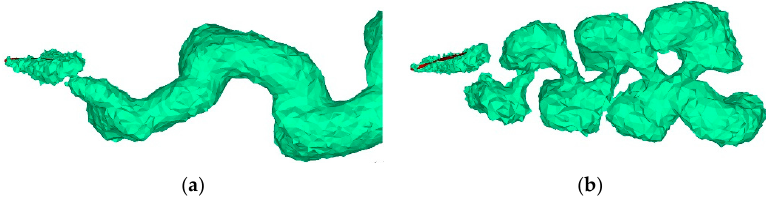
Figure 13. Vortex pattern in the wake: ( a ) h = 0.4 L ; ( b ) h = 0.2 L .